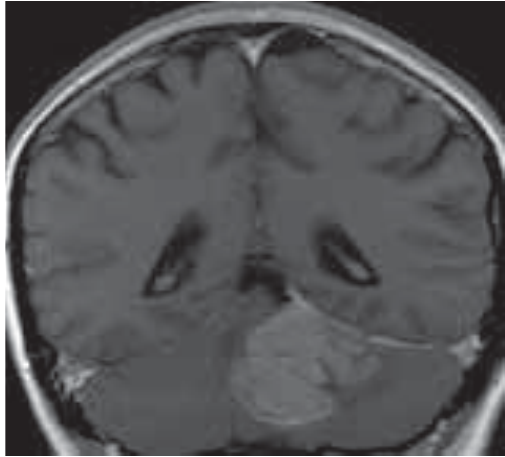
FIGURE 12. The coronal contrast-enhanced T1-weighted image shows intense enhancement in the intra-axial mass in the left cerebellar hemisphere, with the dural tail sign along the left tentorium. Histopathology exam revealed the medul-